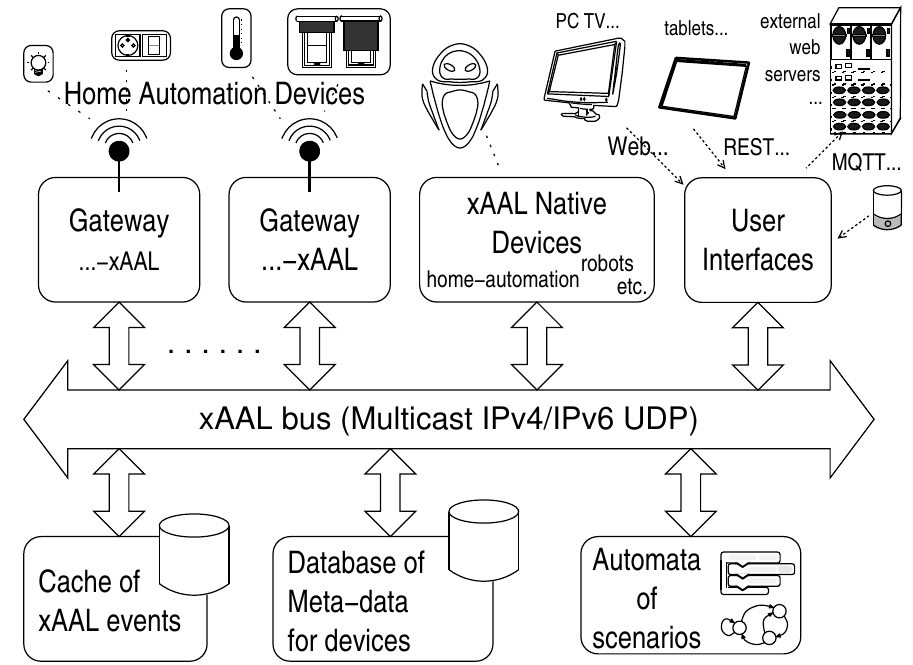
Figure 1. Functional architecture of